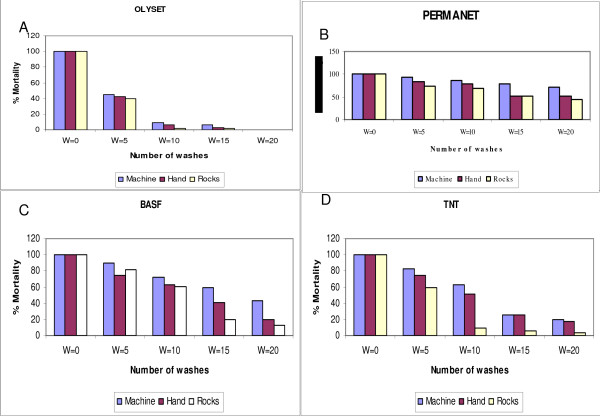
Mortality rates per net type and per washing procedure. The figure shows mortality rates of a susceptible strain of An. gambiae exposed to four different nets after repeated washing using three different washing procedures.